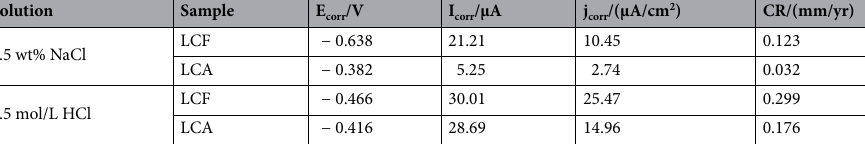
Table 1. Corrosion potentials (E corr ), corrosion currents (I corr ), corrosion current densities (j corr ) and corrosion rates (CR) of LCF and LCA samples in the two different solutions.